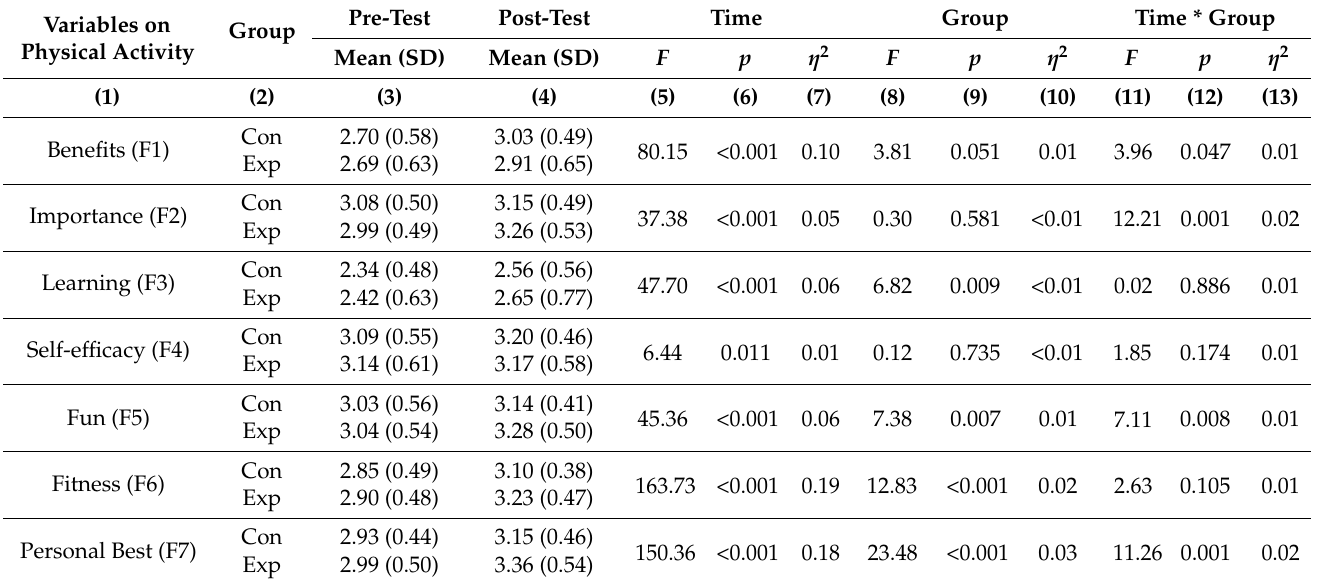
Table 3. Descriptive Statistics and ANOVA Results Before and After Intervention (pre-test vs. post-test) in Experimental Group ( n = 353) and Control Group ( n =